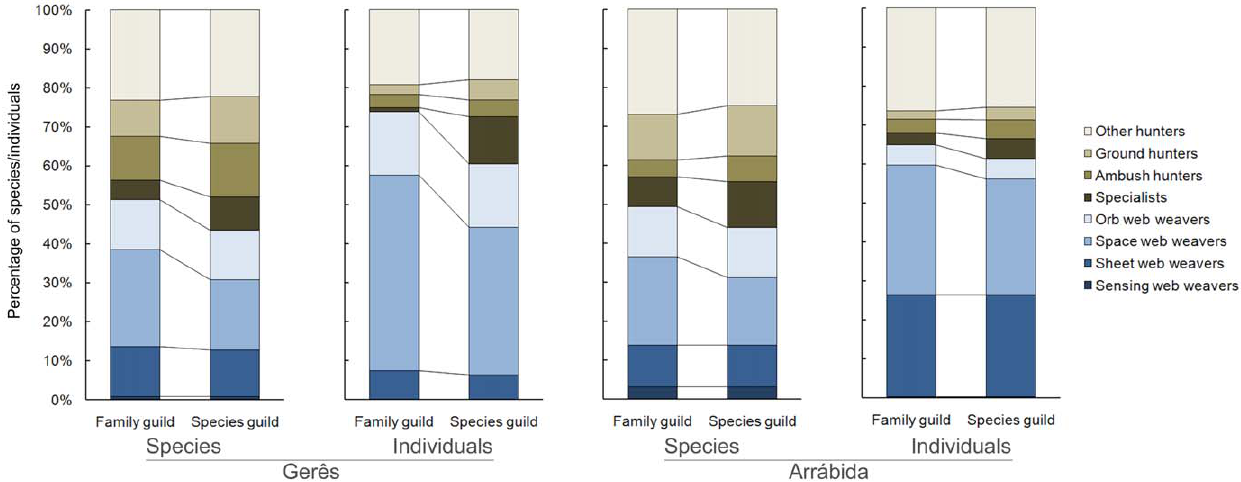
Figure 2. Guild richness and abundance per site with family and species guild classifications. Percentage of species and individuals in each of two sites in Portugal belonging to each guild according to the respective family and species classifications (family classification reflects the predominant guild in the family (Fig. 1), while species classification represents the true guild of the species).